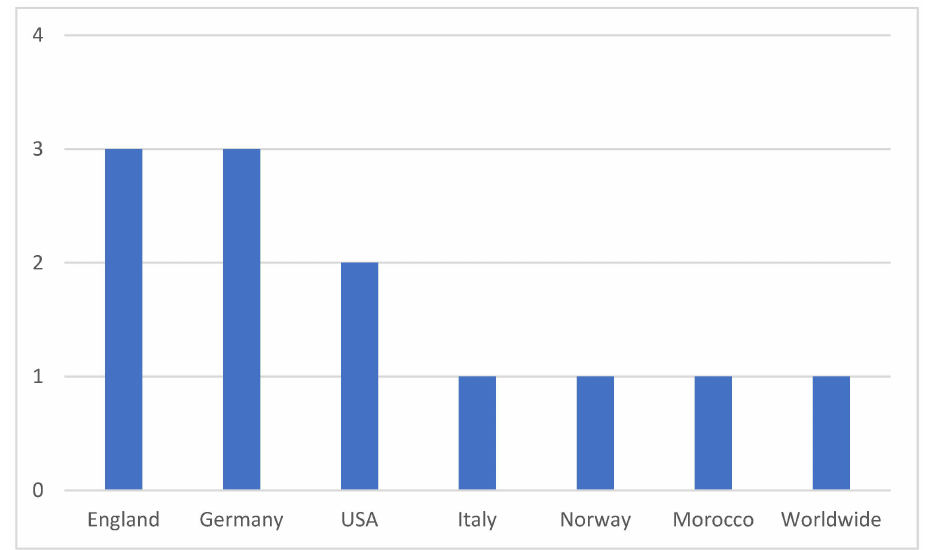
Figure 4. Number of papers per